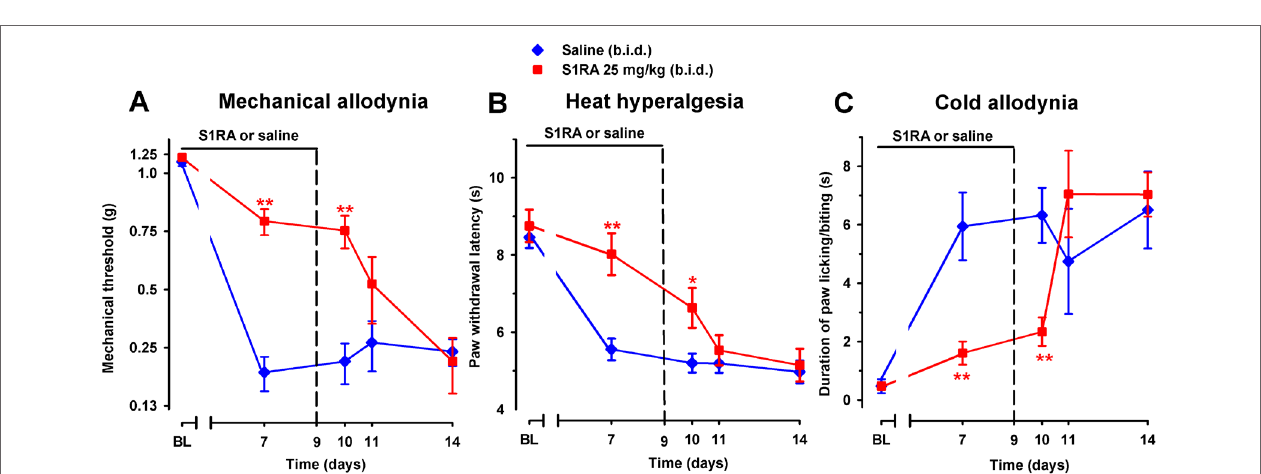
FIGURE 10 | Time course of the effect of repeated treatment with S1RA on mechanical allodynia (A) , heat hyperalgesia (B) , and cold allodynia (C) induced by SNI in female WT mice. The mice were treated twice daily with either saline or S1RA (25 mg/kg, i.p.). The first injection was administrated 30 min before SNI surgery. Responses were recorded in each animal before SNI (baseline, BL) and 30 min after the administration of S1RA or saline on day 7 in the paw ipsilateral to the surgery. Treatment was continued until day 9 and the mice were evaluated again on days 10, 11, and 14 postsurgery. The black horizontal line at the top of each figure illustrates the duration of treatment with S1RA or saline. Each point and vertical line represent the mean ± SEM of the values obtained in 10–14 animals. Statistically significant differences between S1RA- and saline-treated groups on the same day after treatment: * P < 0.05; ** P < 0.01 (two-way repeated-measures ANOVA followed by Bonferroni